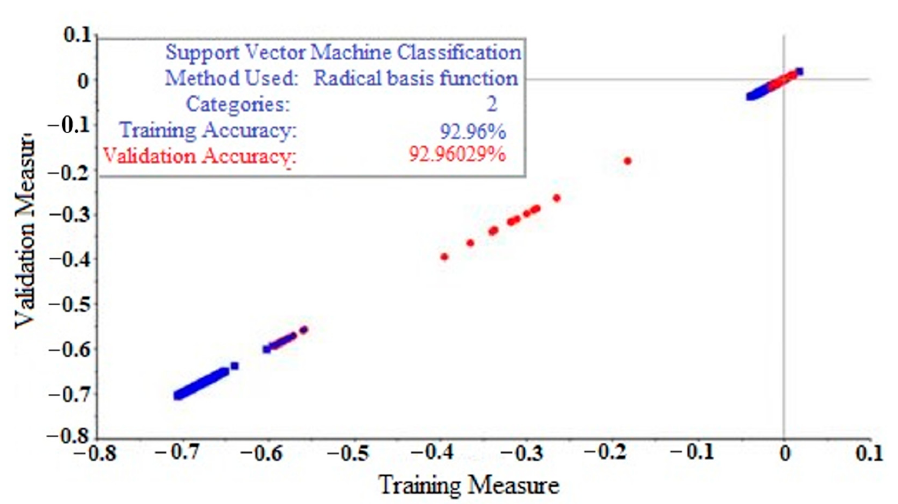
Figure 7. Accuracy of the testing set of Ophiopogon japonicus with SVM for the raw spectra, where blue is the actual value and red is the validation value.